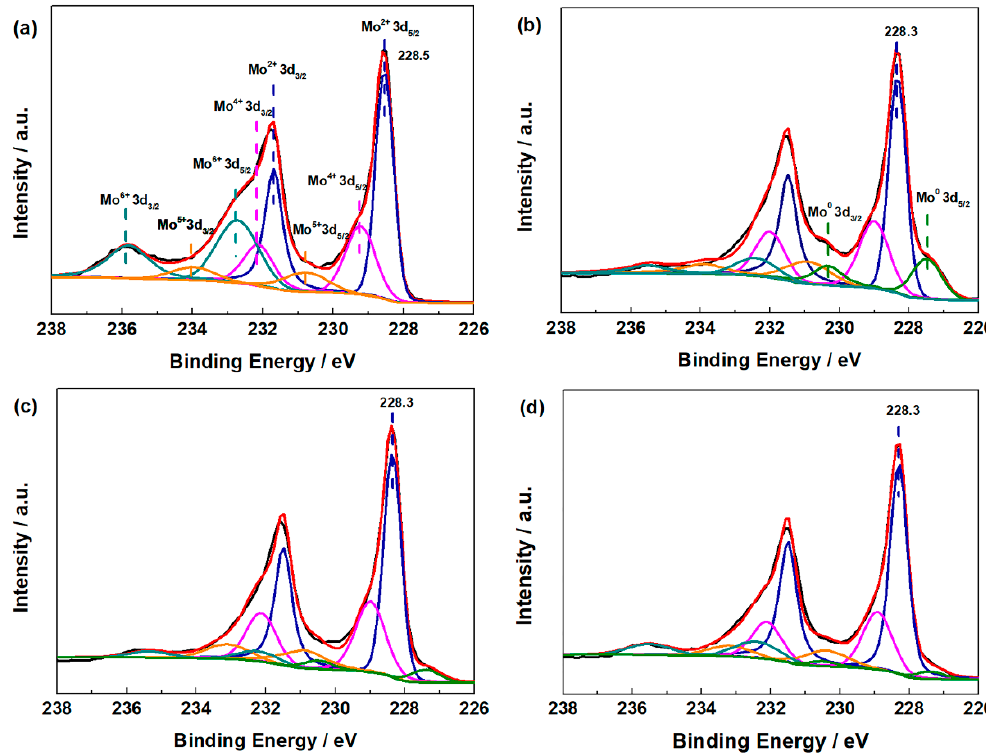
Figure 4. Mo 3 d XPS spectra of ( a ) MC, ( b ) MC-Ni-1, ( c ) MC-Ni-1.5 and ( d ) MC-Ni-2. Mo 0 : green line, Mo 2+ : blue line, Mo 4+ : pink line, Mo 5+ : orange line, Mo 6+ : cyan line.